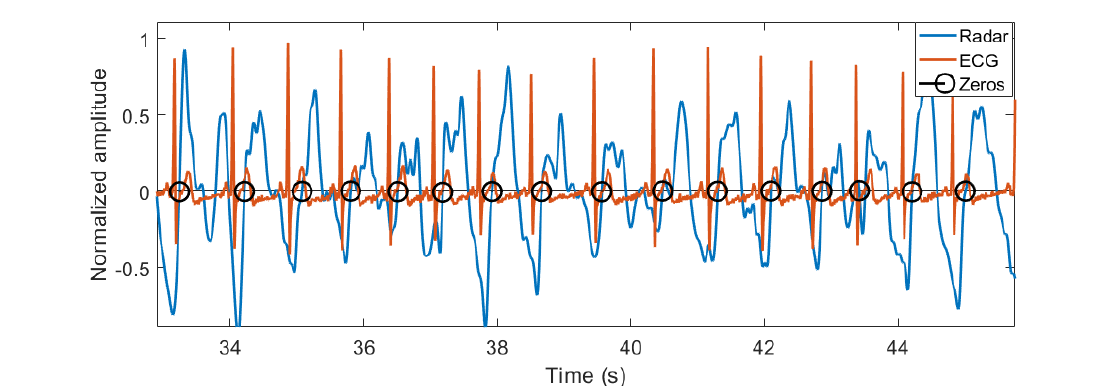
Figure 15. Radar points selected to perform the rHRV